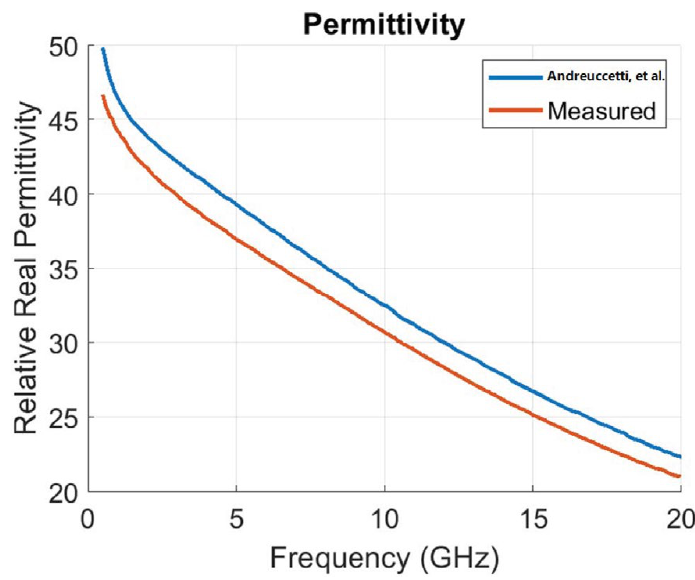
Figure 2. Comparison of reference [30] and measured real permittivity.